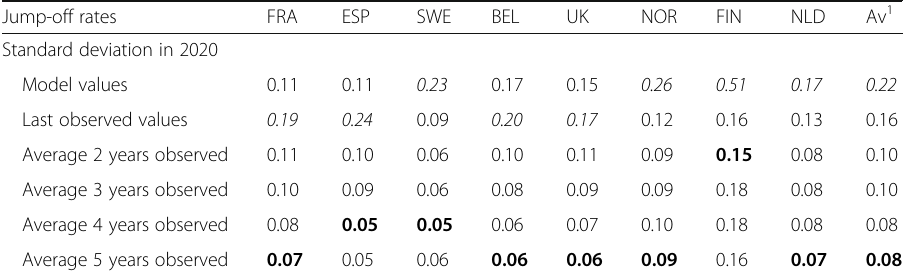
Table 3 Standard deviation (SD) of the increase/decrease of the life expectancy at age 65 in 2020 between ten successive forecasts (fitting periods 1960 – 2005, 1960 – 2006, … , 1960 – 2014) for six different choices of the jump-off rates applied to a Lee-Carter model, for eight Western European countries, men and women